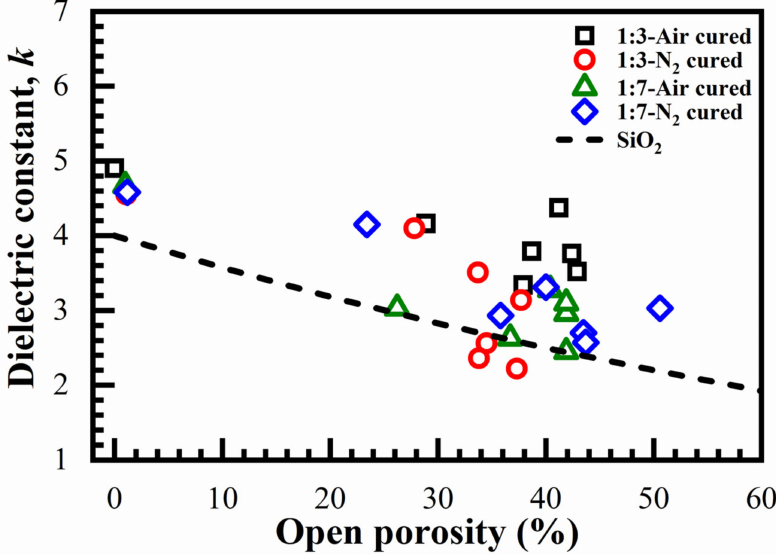
Figure 15. Dependence of the dielectric constant, k (at 100 kHz) on porosity and concentration of benzene bridges for films bake in the air and N 2 for 1:3 and 1:7 materials. The SiO 2 reference is calculated according to the Clausius–Mossotti equation assuming the k of dense SiO 2 is equal to